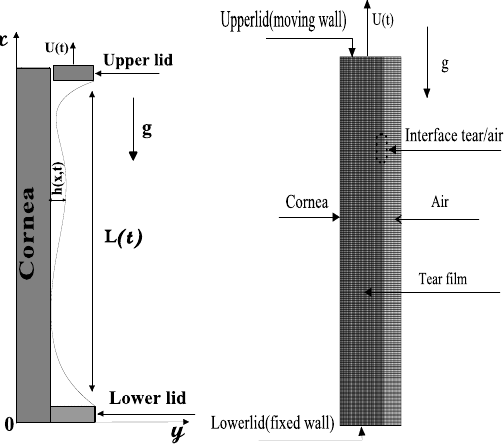
Figure 9. Physical and numerical domain of the tear film problem.